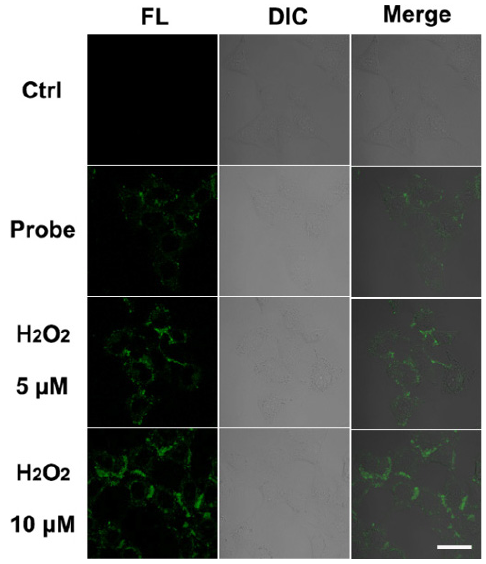
Fig. 3. Confocal °uorescence microscopy imaging of live HeLa cells pre-treated with CBH and di®erent concentrations of H 2 O 2 for 30 min at 37 (cid:2) C. Scale bar represents 20 (cid:1) m.